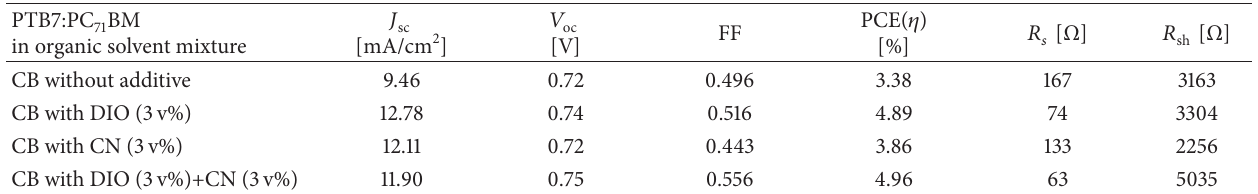
Table 1: Photovoltaic parameters of the four different organic thin film solar cell devices based on blended active layer of PTB7:PC prepared with different organic solvent mixture.